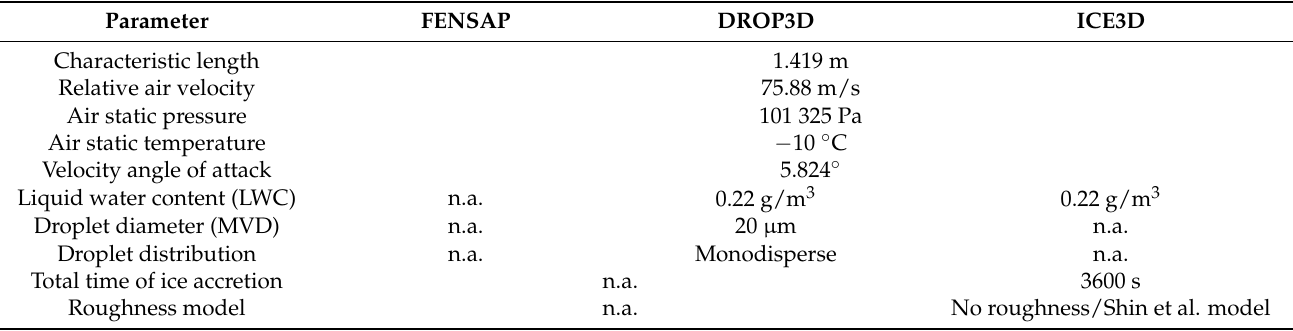
Table 2. Setup for each ANSYS FENSAP-ICE